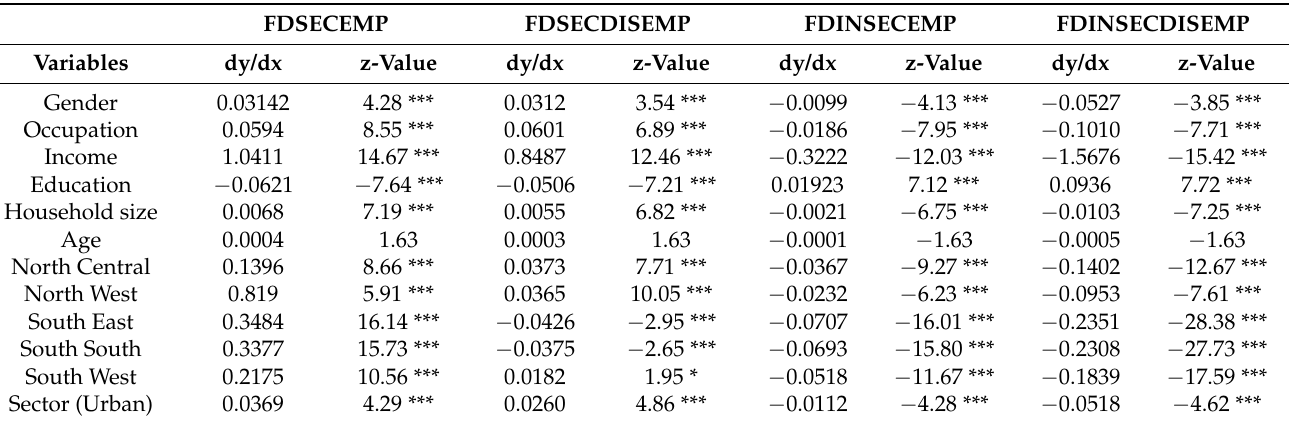
Table 11. Ordered probit model estimates of the determinants of empowerment in relation to food security status of households in